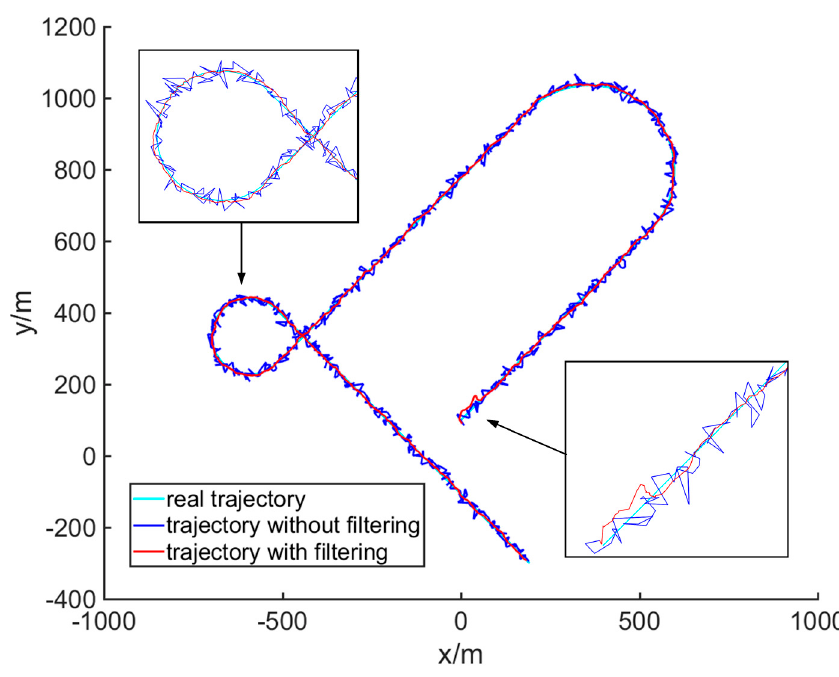
Figure 12. Trajectory and position estimation of the moving target.